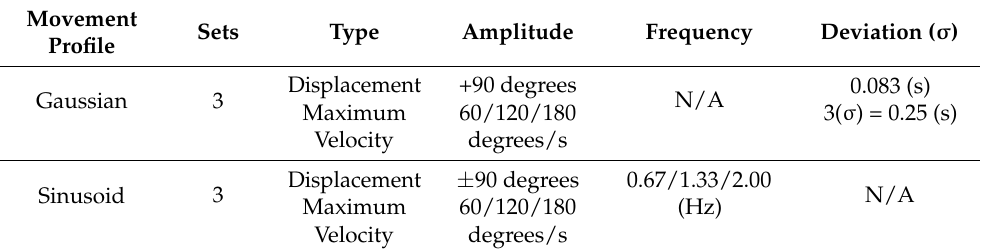
Table 1. To test the performance of the single-axis joint angle tracking system, two movement profiles, Gaussian and sinusoidal, were chosen. For each profile, three different velocities were tested. Movement Sets Type Amplitude Frequency Deviation ( σ ) Profile Displacement +90 degrees 0.083 (s) N/A Gaussian 3 60/120/180 3( σ ) = 0.25 (s)Maximum Velocity degrees/s Displacement ± 90 degrees 0.67/1.33/2.00 N/A Sinusoid 3 Maximum 60/120/180 (Hz) Velocity